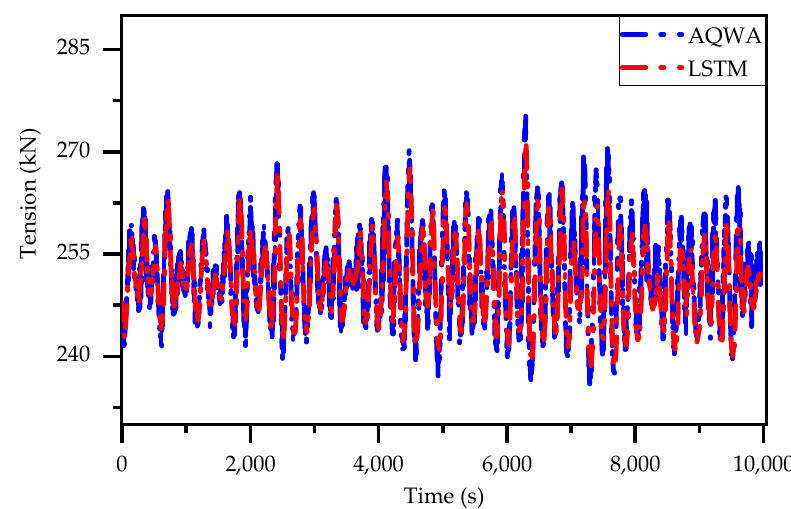
Table 13. Result statistics of AD10.